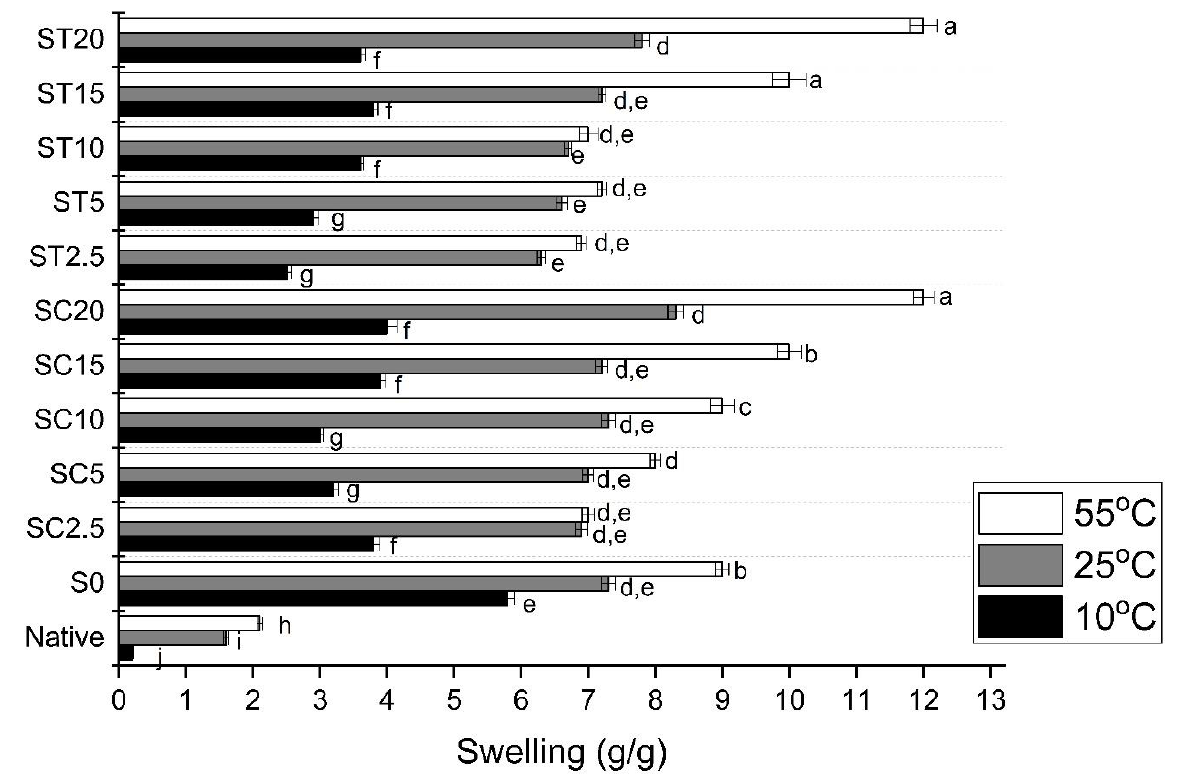
Figure 5. Effect of temperature on swelling of native starch, the control sample (extruded without reagent) and starch hydrogels obtained by reactive extrusion through reaction with CA and TA. Different letters indicate significant difference between means by Tukey’s test ( p ≤ 0.05).